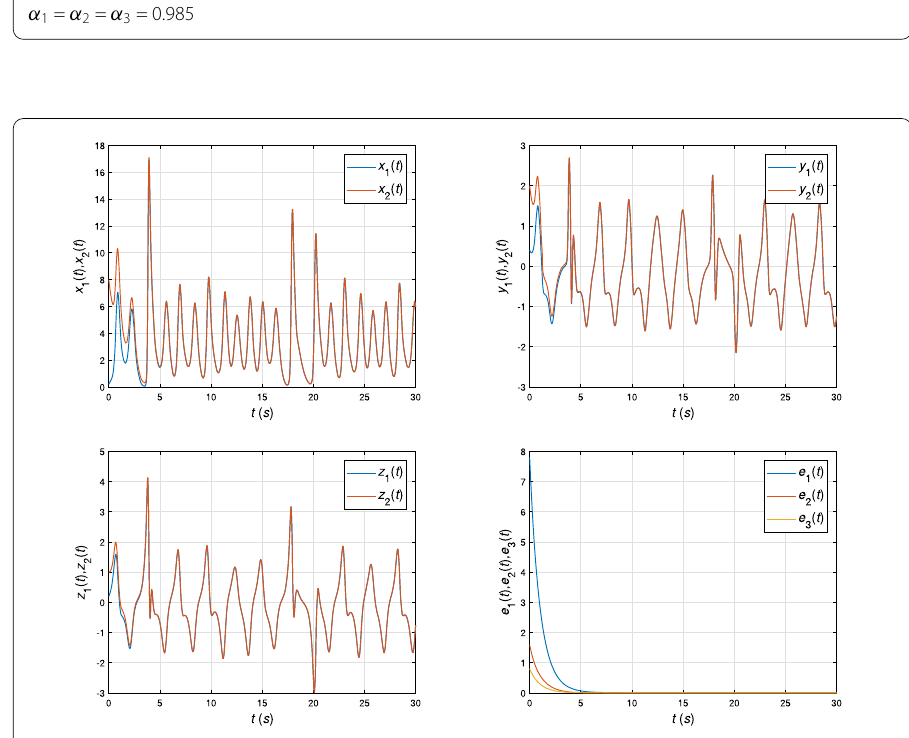
Figure 11 Synchronization results between two nonidentical fractional-order systems (37) and (38) for α 1 = α 2 = α 3 =